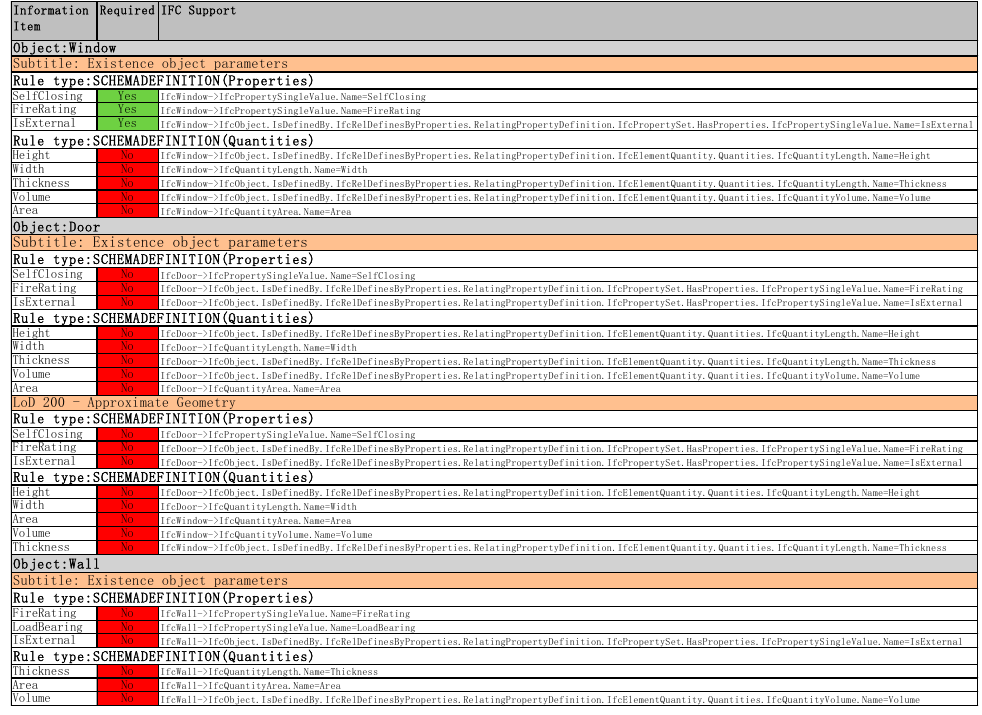
Figure 3. Excel data source.